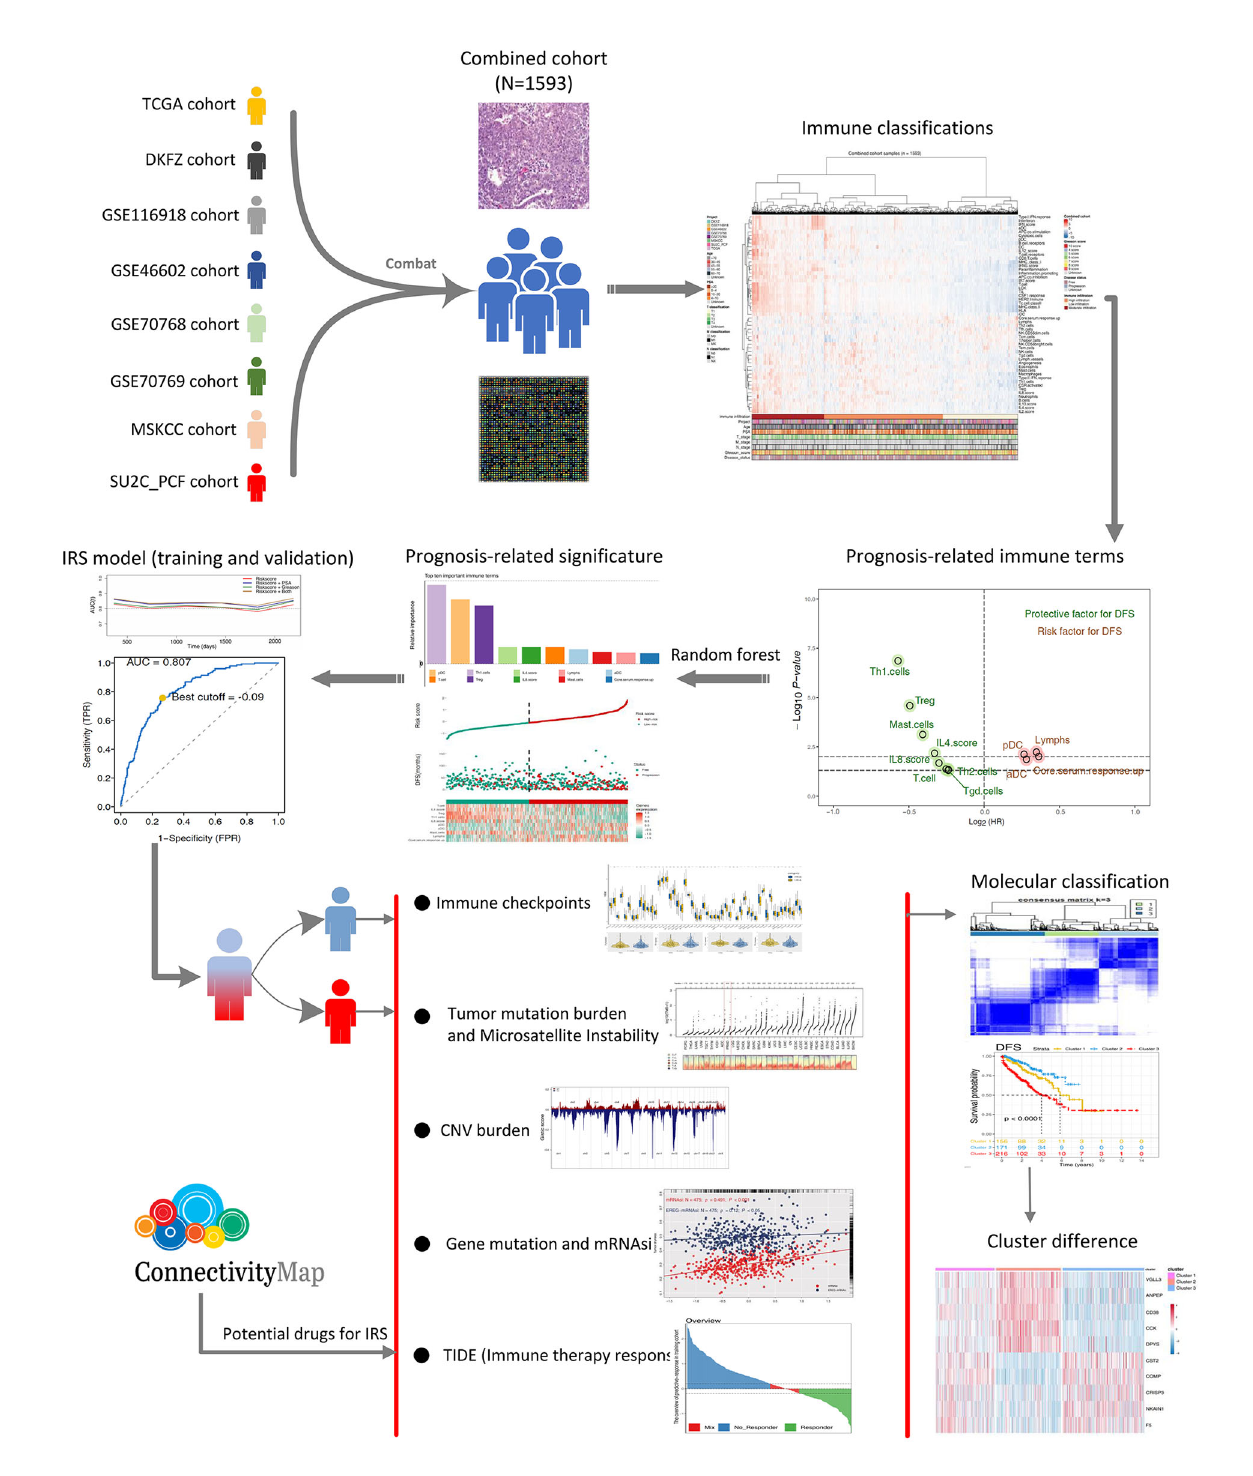
FIGURE 1 | The whole fl owchart of the analysis based on large PCa cohorts. Eight independent PCa cohorts were included for our analysis and further combined into a large population PCa cohort using sva package. Expression pro fi le of all patients was quanti fi ed as 53 immune terms using ssGSEA package. Top 10 important immune terms identi fi ed from random forest algorithm were used for IRS caculation. Then, we found that high IRS patients showed poor clinical features, genomic character, and biological pathway associated with poor prognosis of PCa poor clinical outcomes. Meanwhile, it also could predict the immunotherapy response rate of PCa